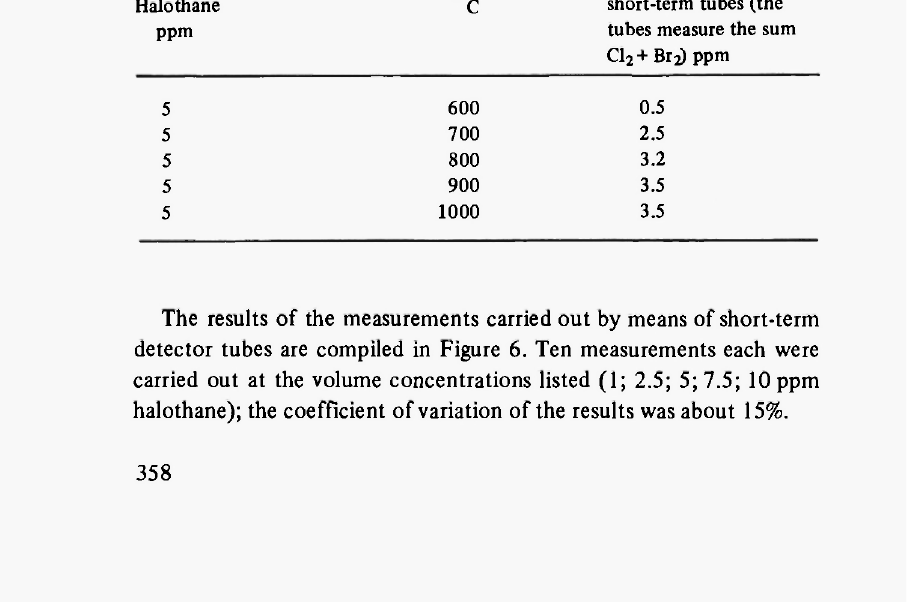
Volume concentration Temperature Indication of the chlorine Halothane ° C short-term tubes (the ppm tubes measure the